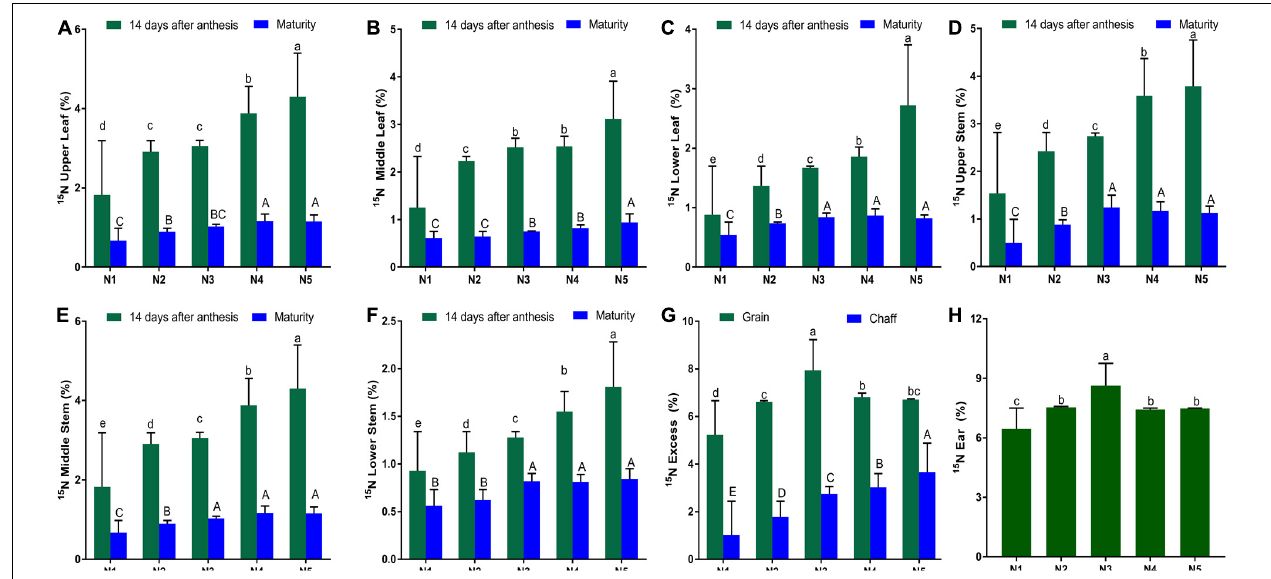
FIGURE 2 | Effect of N fertilization on 15 N excess (in atom %) of different spring wheat organs with 15 N labeling. (A) Upper leaf. (B) Middle leaf. (C) Lower leaf. (D) Upper stem. (E) Middle stem. (F) Lower stem. (G) Grain and chaff. (H) Ear at 14 days after anthesis. Bars with the same color with the same/a common alphabet indicates no significant difference with Duncan Multiple Range Test at 5% probability level and those with different alphabets mean otherwise. Error bars indicate the standard error.